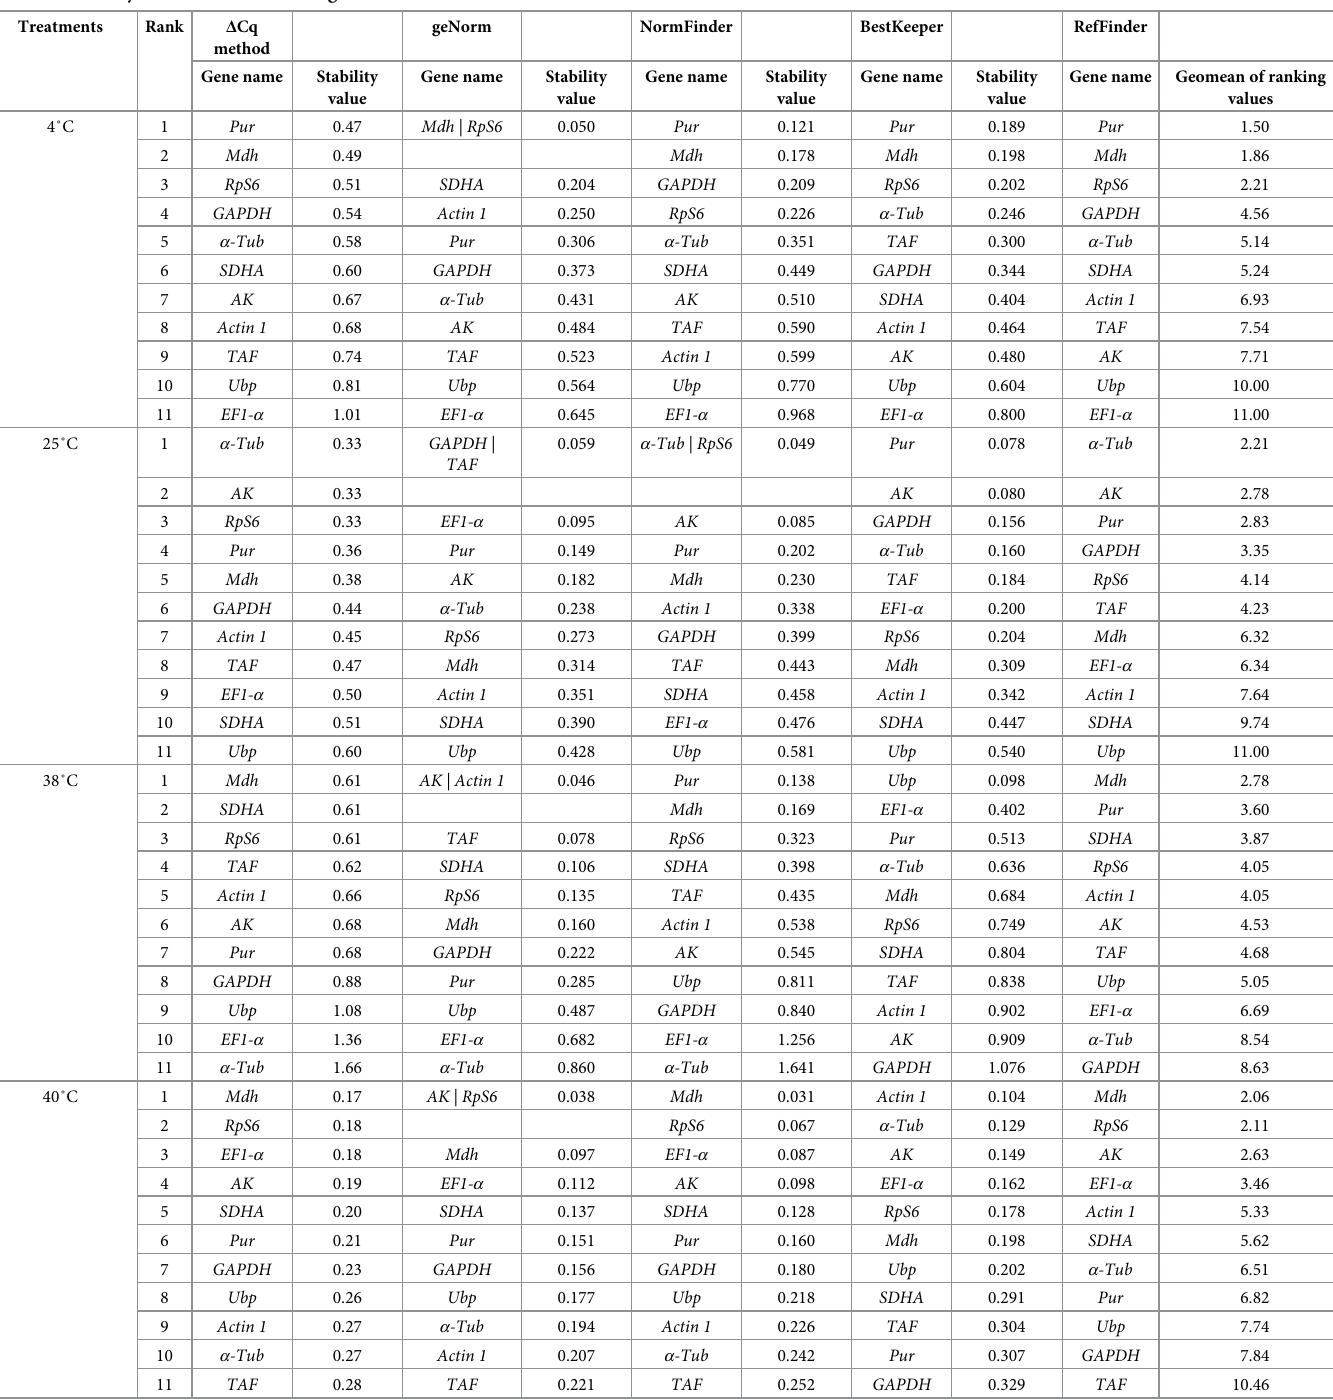
Table 2. Stability of candidate reference genes under different treatments.